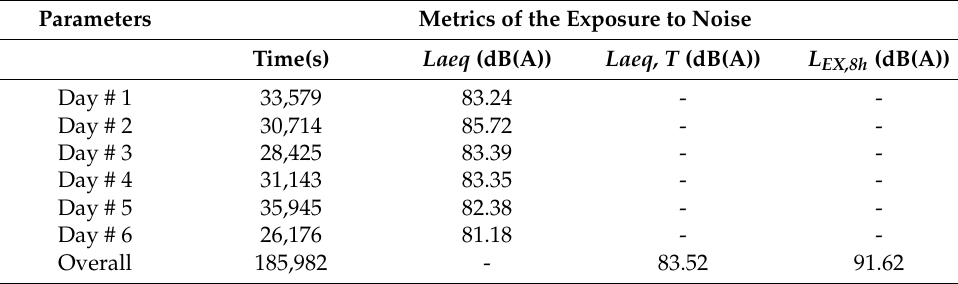
Table 3. Statistics of the exposure to